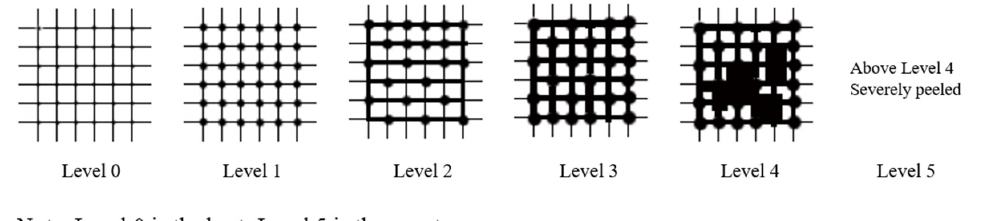
Figure 3. Standard of the adhesion